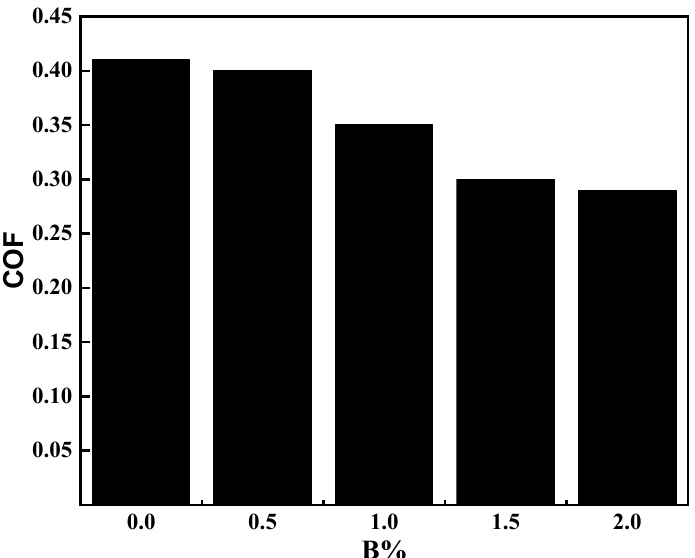
Figure 11. Comparison of friction coefficients of surfacing layers with different amounts of